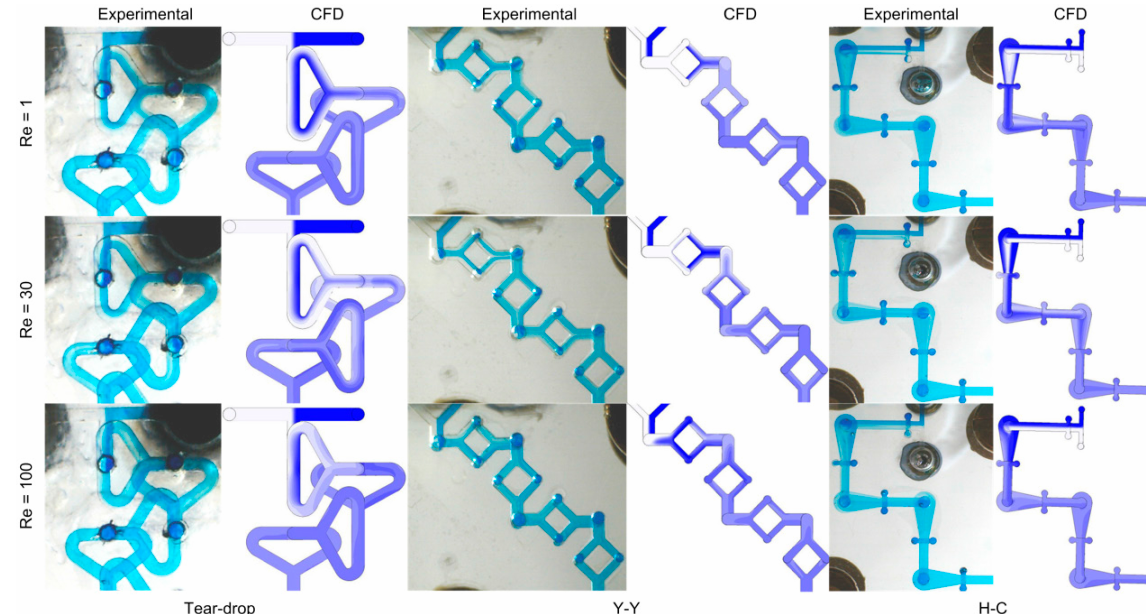
Figure 7. Comparison between the images of the Tear-drop, the Y-Y, and the H-C mixers taken from computer simulation and experiments.